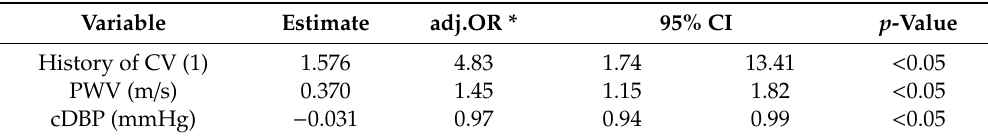
Table 5. Multivariate logistic